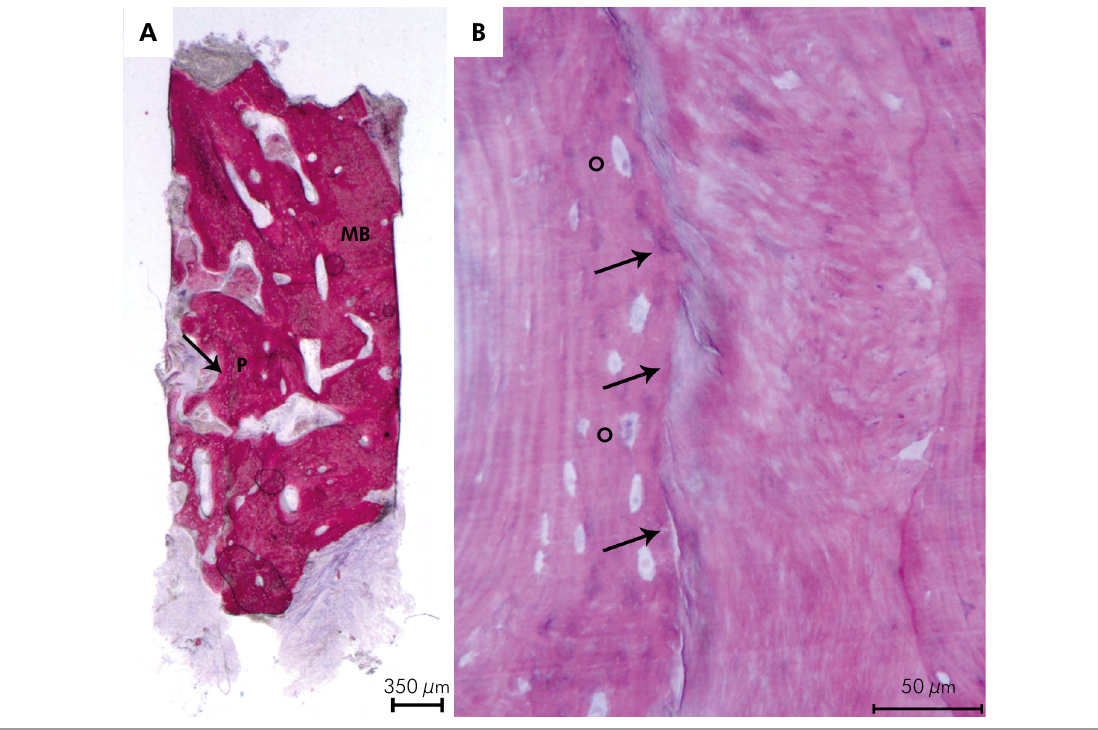
Figure 2. Low power magnification image of Group 1 sample (bone chips). (A) It was possible to distinguish two areas with different features: pre-existing bone with small marrow spaces (*) (MB) and new bone (black arrow) surrounding bone chips (**) (P) (Toluidine blue and acid fuchsin 12x); (B) A thin layer of necrotic bone (arrows) marked out the two areas: on the right-hand side remodeling areas could be observed, whilst on the left-hand side wide osteocyte lacunae (O), typical of young bone, were present. (Toluidine blue and acid fuchsin, 200 x).